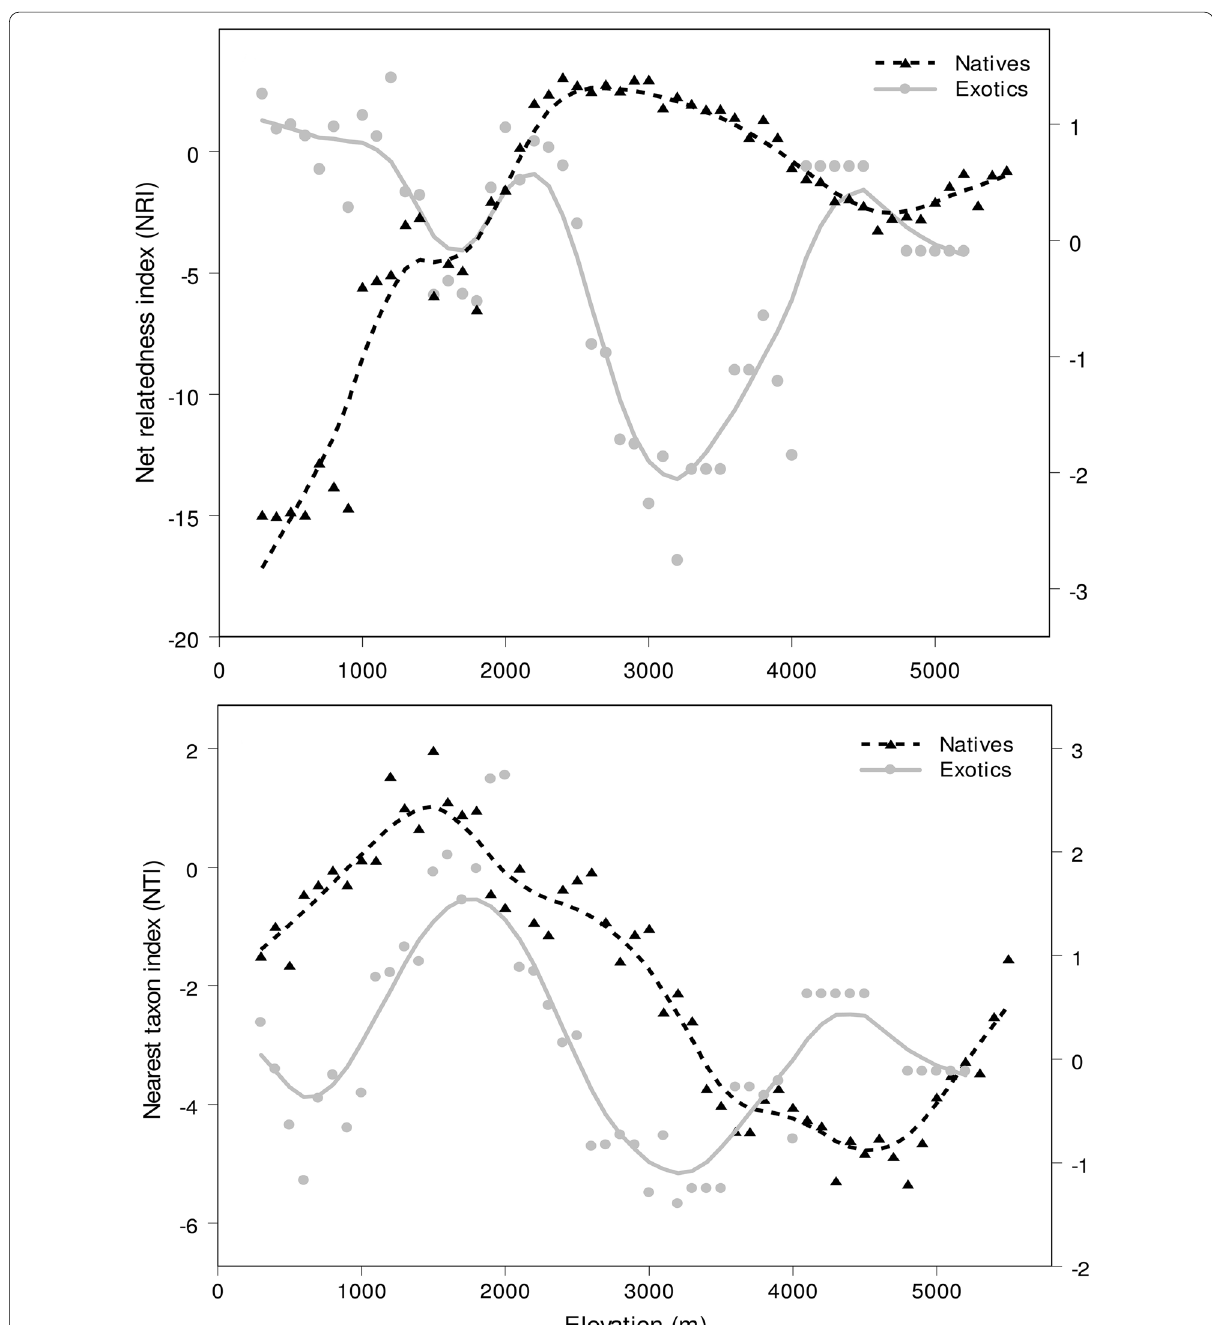
Fig. 5 Plots showing the variation of phylogenetic structure of exotic and native plant species along the Sikkim Himalayan elevational gradient. Phylogenetic structure was measured using net relatedness index (NRI) and nearest taxon index (NTI). Overall, exotics showed phylogenetic clustering (NRI and NTI > 0) and natives showed phylogenetic overdispersion (NRI and NTI < 0) along the elevational gradient. In both the plots, the primary Y -axis represents NRI and NTI values of native species, while secondary Y -axis represents NRI and NTI values of exotic species. The fitted lines in both the plots were generated using Friedman’s super smoother function and do not imply any cause–effect